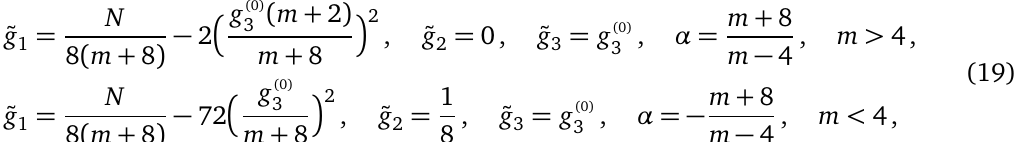
Figure 1: Conformal manifolds (14) for x = 1 / 4 (brown). Black points correspond to ˜ g x 1 common for all x . Orange surface, (18) with x 1 two points (with positive and negative ˜ g α = 1, and large but finite N . Theory with positive ˜ g enhanced to O ( N ) , while the theory with negative ˜ g exhibits persistent symmetry breaking O ( m ) × O ( N − m ) → O ( m − 1 ) × O ( N − m )